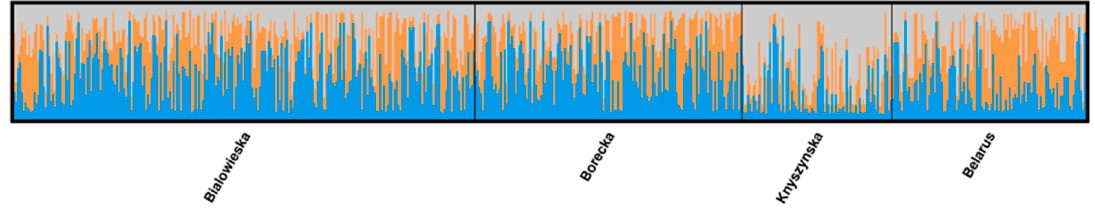
Figure 6. Structure plot that shows the genetic affiliation of LB line individuals from 4 different herds with groups computed by the program. The plot represents the run when K = 3. Individuals are ordered by origin, each represented by a line proportionally divided into color segments. Each color represents one genetic group. Black lines separate the individuals from different herds.